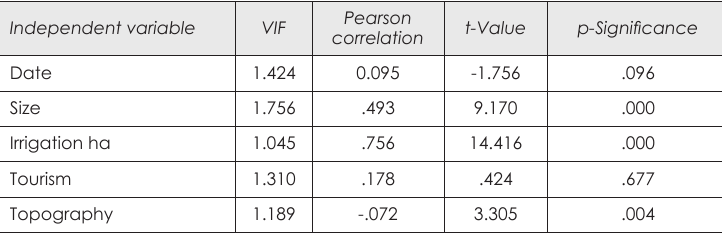
Model 3 regression correlations and